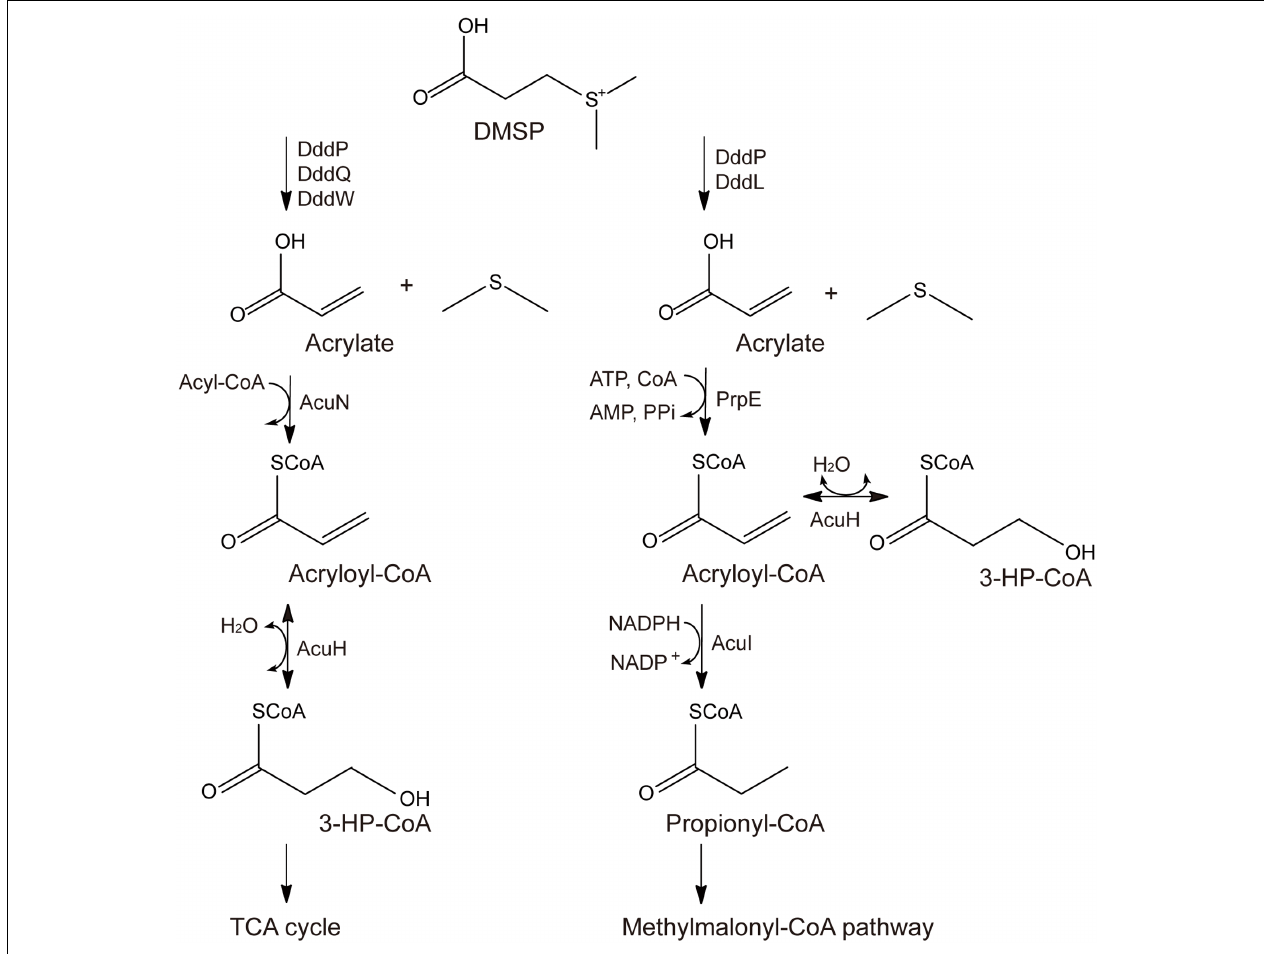
FIGURE 1 | Proposed metabolic pathways for acrylate detoxification. The left is the AcuN-AcuK pathway in Halomonas sp. HTNK1 (Curson et al., 2011; Reisch et al., 2013), and the right is the PrpE-AcuI pathway in Ruegeria pomeroyi DSS-3 (Curson et al., 2011; Reisch et al., 2013).